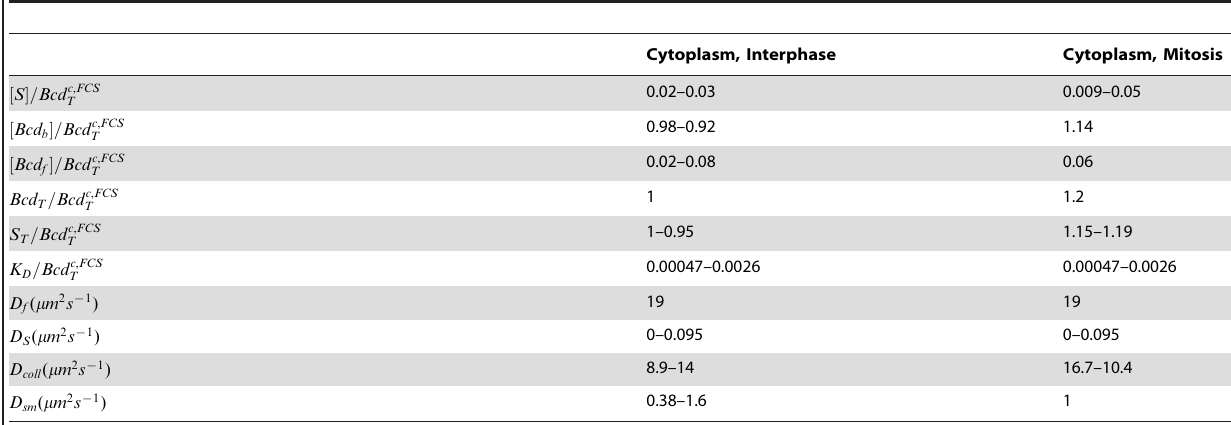
Table 2. Estimates of equilibrium concentrations and of model parameters derived from experiments performed in the cytoplasm.